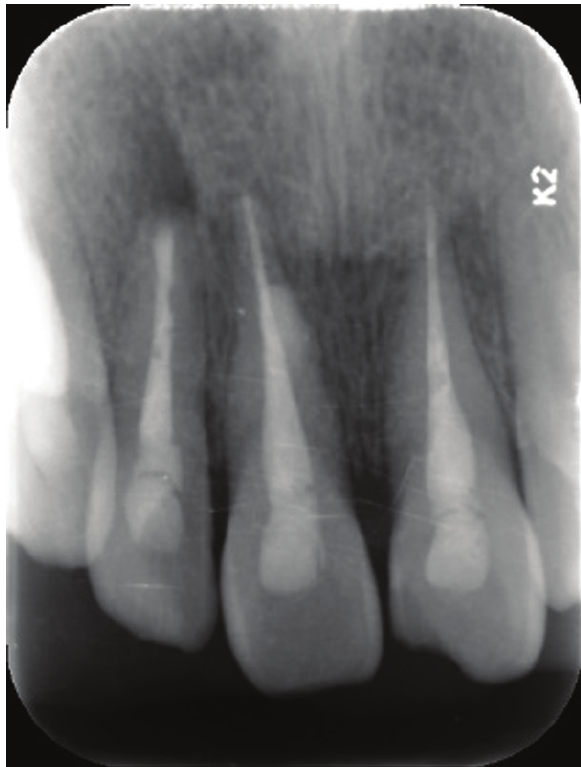
Fig. 7. Postoperative radiograph indicating that the lesion of tooth 11 was filled, the lesion of tooth 12 was removed, and the root-end cavity was adequately